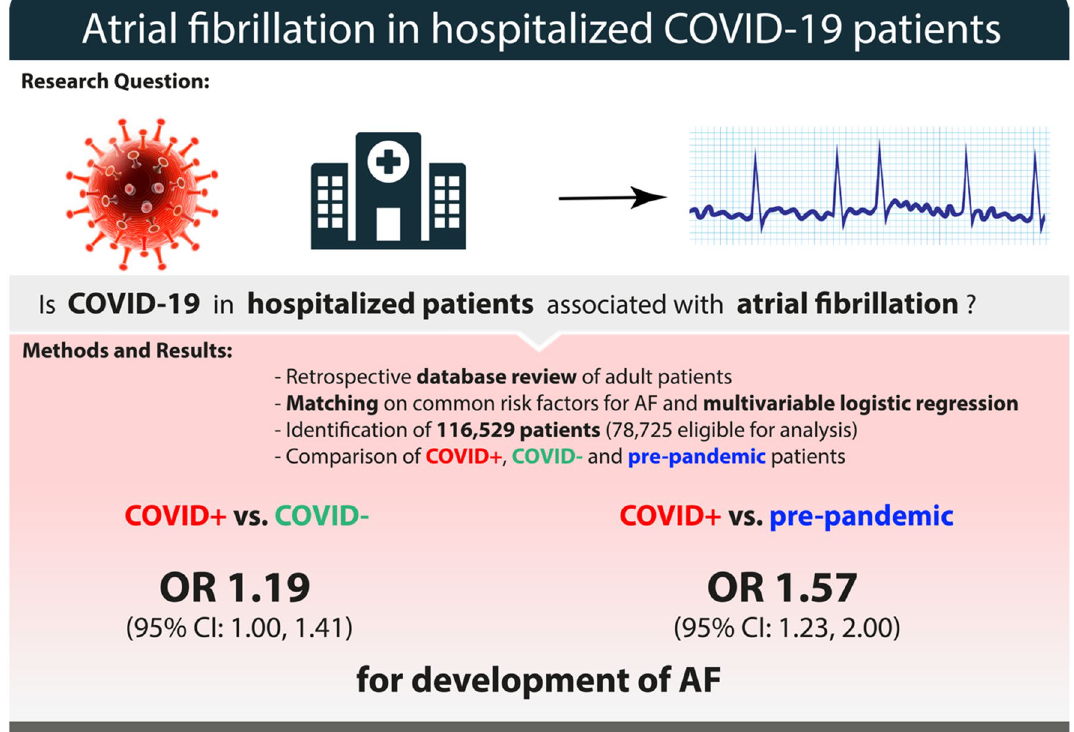
Figure 3. Summarizing figure of the study’s